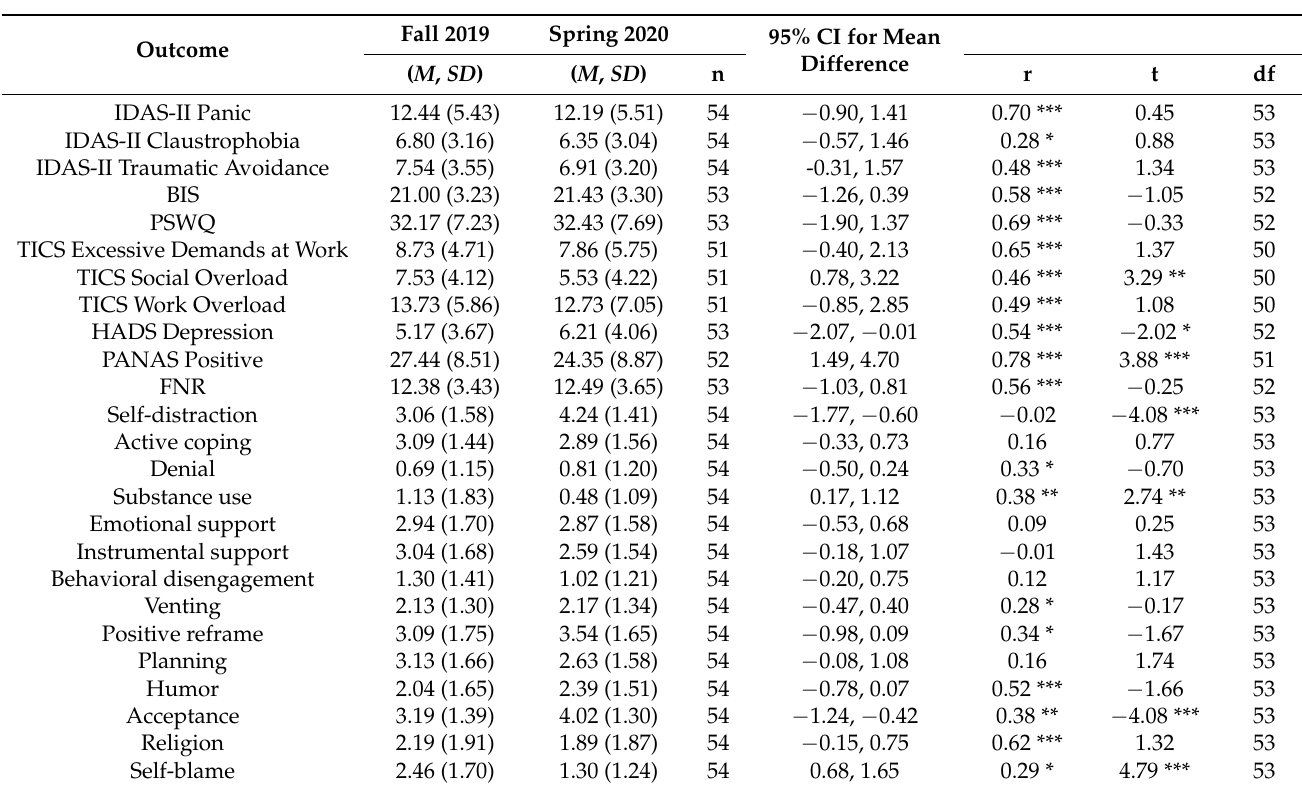
Table 4. Change in proposed Research Domain Criteria Negative Valence Systems construct measures and coping strategies during the